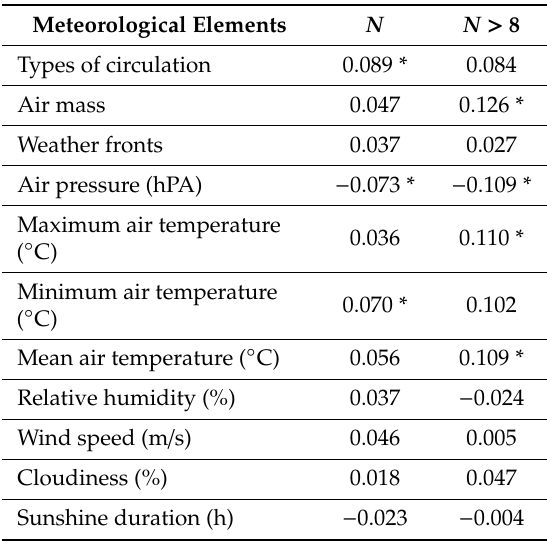
Table 1. Results of Spearman’s rank test examining the association between coercive interventions among hospital patients ( N —days with all coercive interventions, N > 8—days with nine or more, *— p < 0.05) and meteorological parameters in